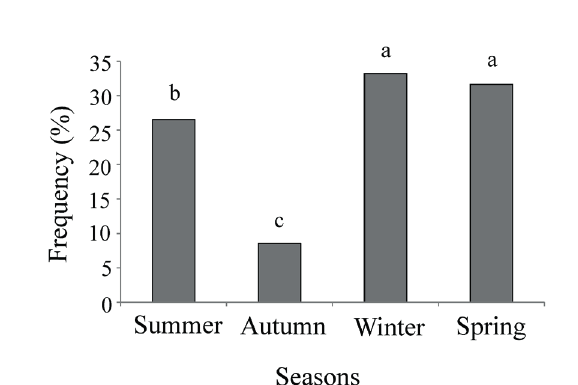
Figure 4. Relative frequency (%) of juveniles of Hyalella bonariensis from Silveira Martins, state of Rio Grande do Sul, Brazil. Columns with at least one letter in common are not significantly different